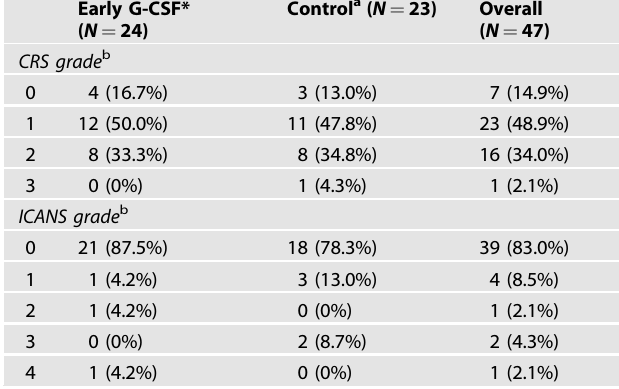
Table 6. Baseline characteristics in multiple myeloma cohort. Table 7. Maximum CRS and ICANS in multiple myeloma